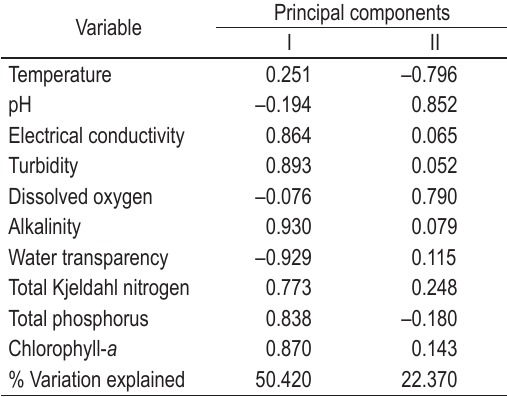
Table 2. Correlations of the limnological variables of the reservoir water with components I and II of the Principal Components Analysis